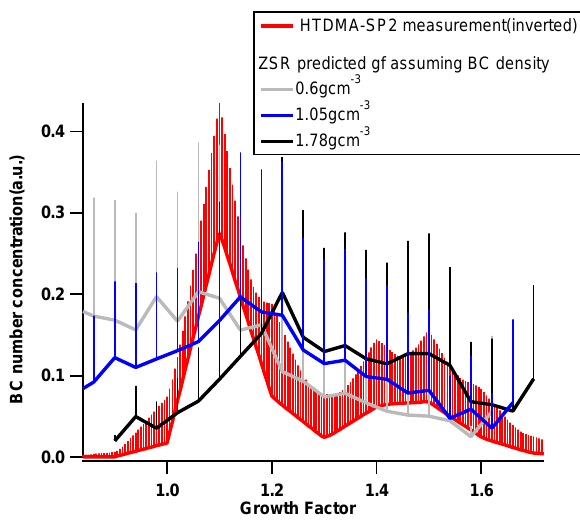
Fig. 9. A comparison between HTDMA-SP2 measured gf of BC- containing particles and ZSR predicted gf by resolving the BC mix- ing state. The error bars show the + σ (standard deviation) for the entire experimental